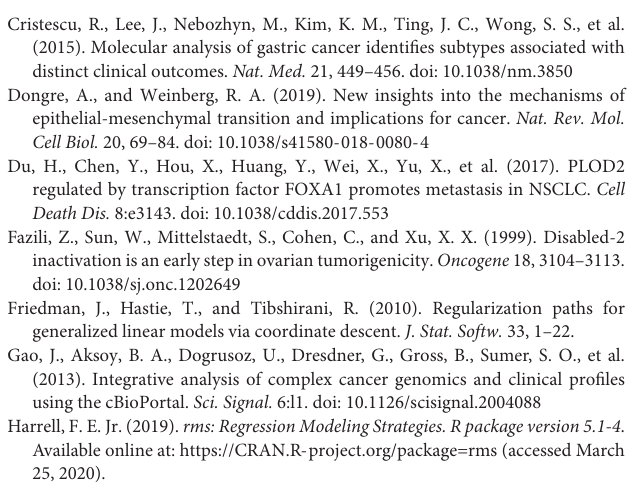
Supplementary Figure 1 | Correlation plot of 10 prognostic EMT-related genes in the TCGA cohort. Supplementary Figure 2 | Confirmation of the signature for OS prediction in clinical subgroups stratified according to gender. (A,B) Kaplan-Meier estimates of OS based on the EMT-related gene signature in subgroups classified by gender in the TCGA-STAD (A) and the GSE62254 (B) cohorts. Supplementary Table 1 | List of the primers used for qRT-PCR. Supplementary Table 2 | 123 significantly differentially expressed EMT-related genes. Supplementary Table 3 | Multivariate Cox regression of TCGA-STAD and GSE62254 cohorts with variables including age, gender, stage, LNR and risk score. Supplementary Table 4 | Clinical characteristics of TCGA-STAD cohort patients in different risk groups. Supplementary Table 5 | Clinical characteristics of GSE62254 cohort patients in different risk groups. Supplementary Table 6 | The profiles of the EMT-related gene signature based nomogram and models with different factors’